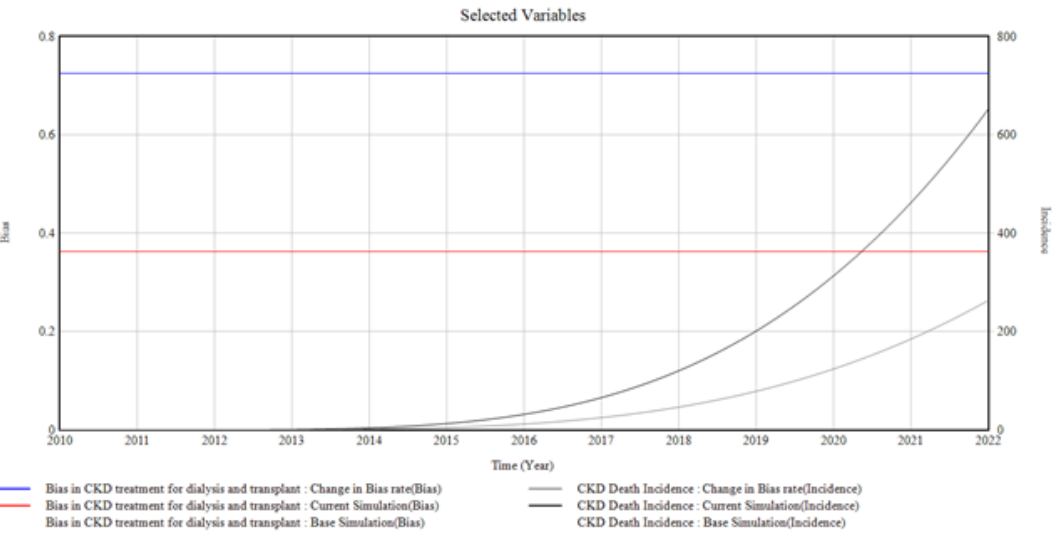
Figure 8. The Bias Rate in ESRD vs. CKD Death